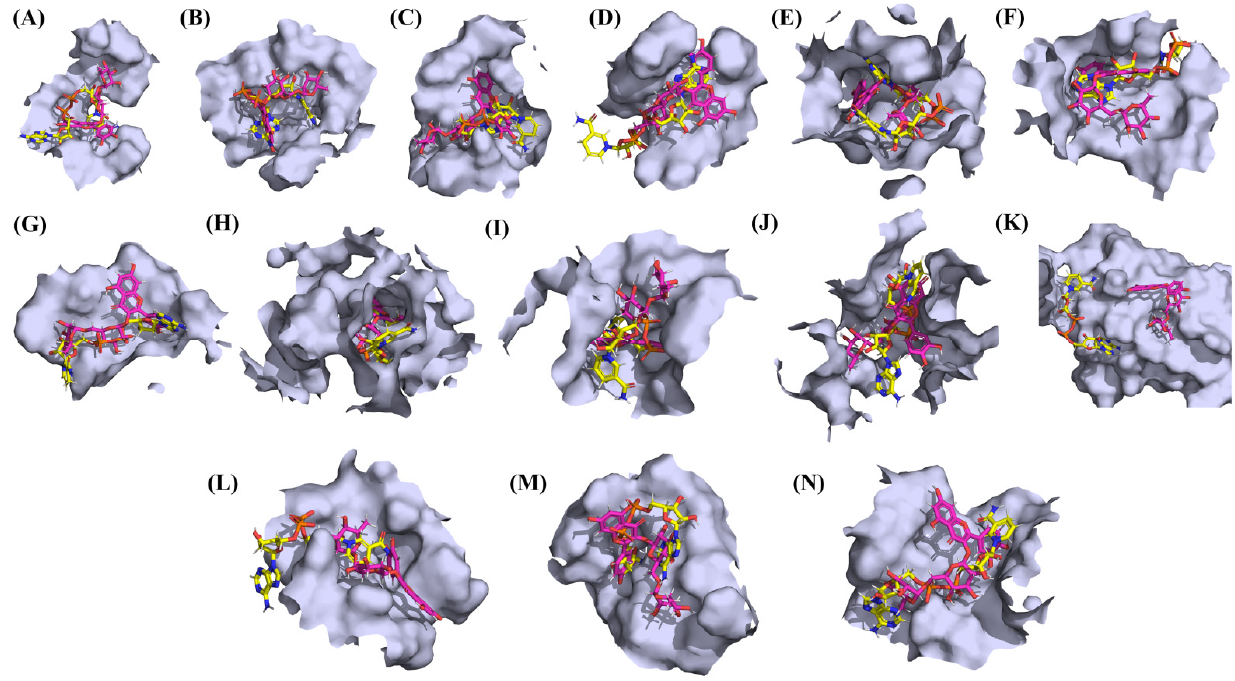
Figure 16. The binding of rutin (pink) and NADH (yellow) in the pockets of 14 different SARS-CoV-2 proteins. (A) NSP1. (B) NSP3. (C) NSP5. (D) NSP9. (E) NSP12. (F) NSP13. (G) NSP15. (H) ORF3a. (I) S. (J) E. (K) M. (L). ORF6. (M) ORF7a. (N) N Proteins.